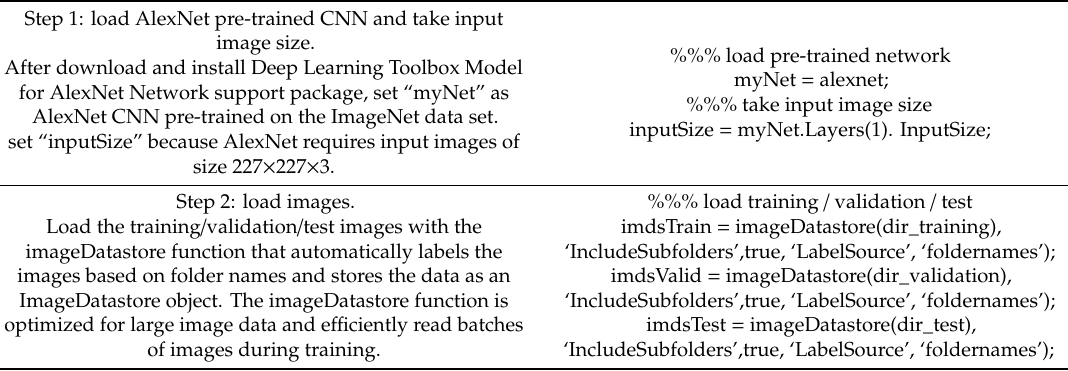
Table 4. Steps for the fine-tuning of the pre-trained AlexNet network.